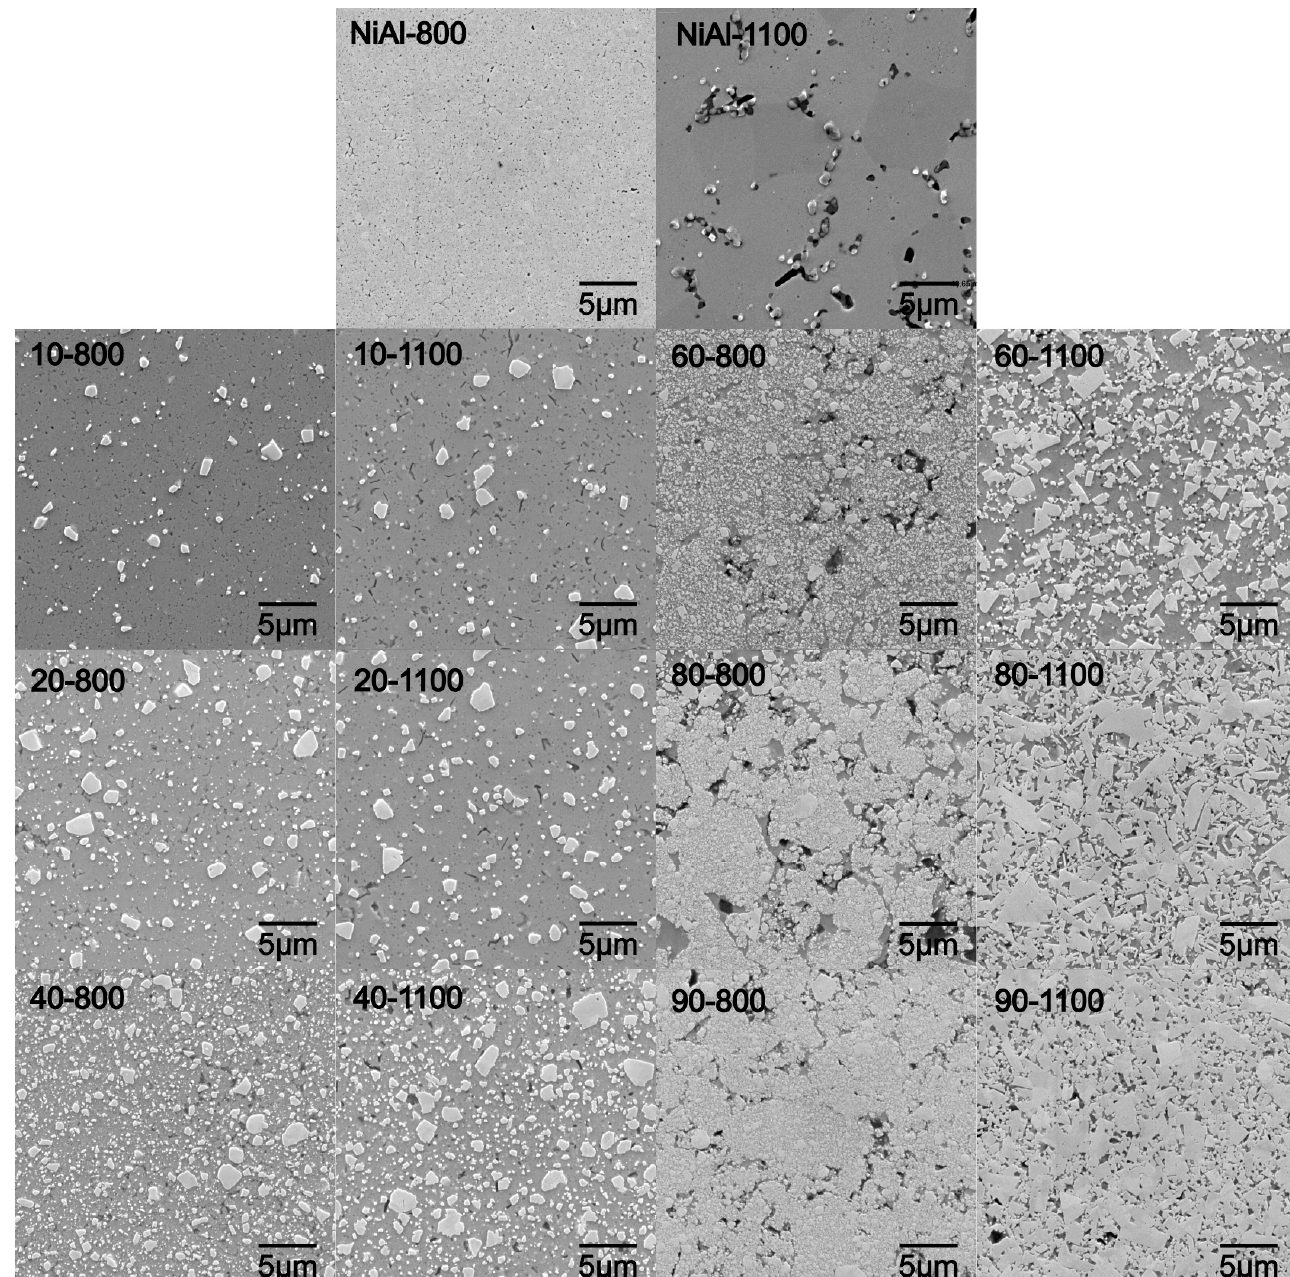
Figure 10. SEM microphotographs of NiAl-xWC samples sintered at 800 °C and 1100 °C.